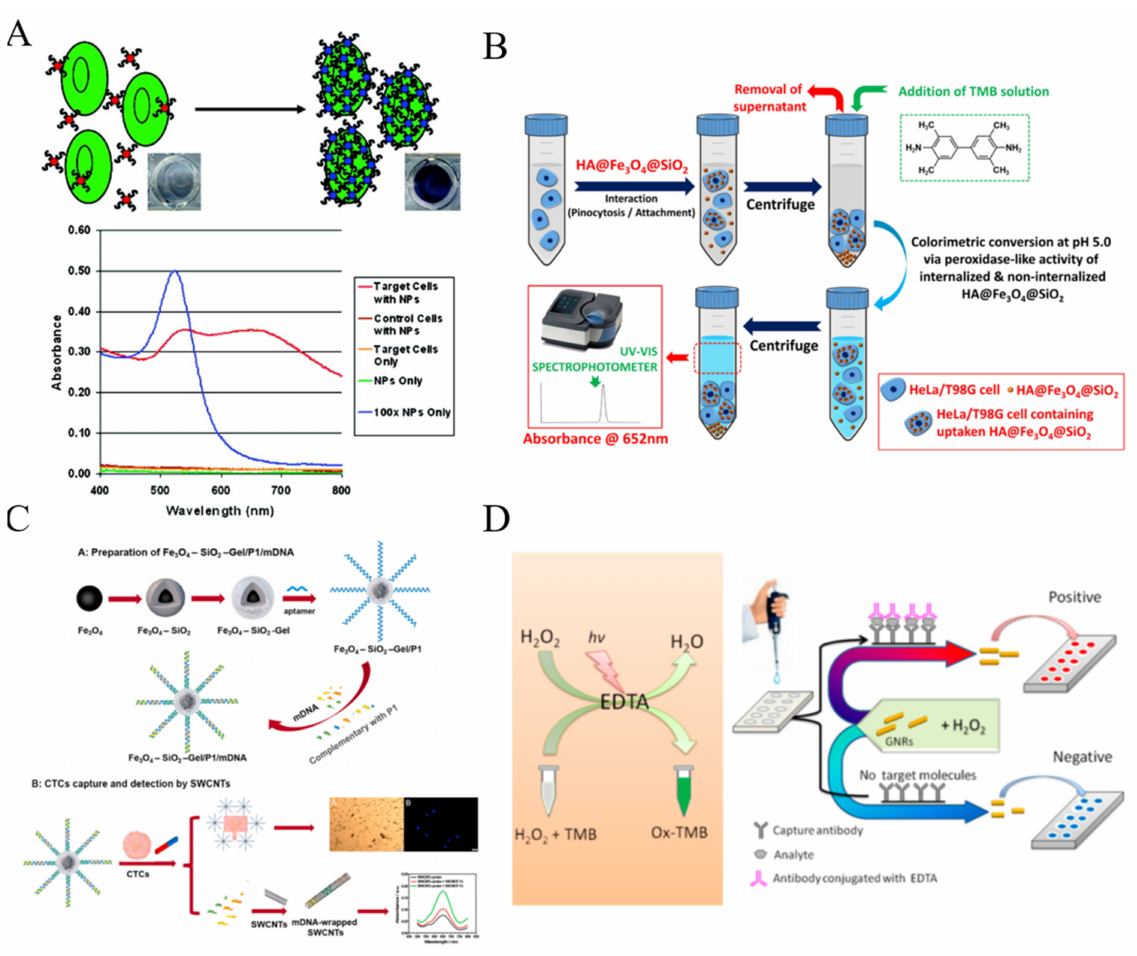
Figure 5. ( A ) Schematic representation of the ACGNP based colorimetric assay [97]. Copyright 2008 American Chemical So- ciety. ( B ) Schematic representation of colorimetric protocol developed for determination of HeLa or T98 G cell concentration based on the variation of peroxidase-like activity of cell internalizable HA@Fe 3 O 4 @SiO 2 microspheres [100]. Copyright 2020 Elsevier B.V. ( C ) Schematic representation of Fe 3 O 4 –SiO 2 -Gel/P1/mDNA, CTCs capture and subsequent colorimetric detection of the captured CTCs by SWCNTs colorimetric probe [101]. Copyright 2021 Elsevier B.V. ( D ) Schematic represen- tation of visual read-out for determination of CTCs by combining EDTA-based sensor with immunomagnetic separation of CTCs from blood [105]. Copyright 2017 American Chemical